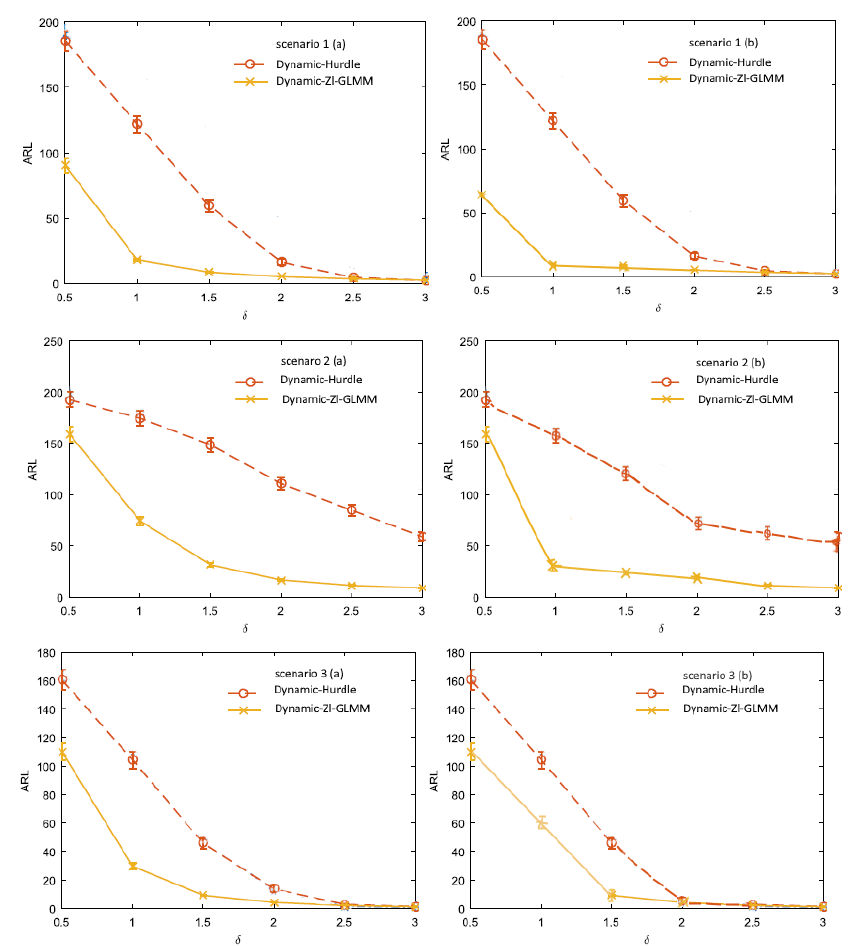
Figure 1. Comparison of average run length (ARL) using simulation data in the performances of different scenarios. Smaller ARL values indicate better